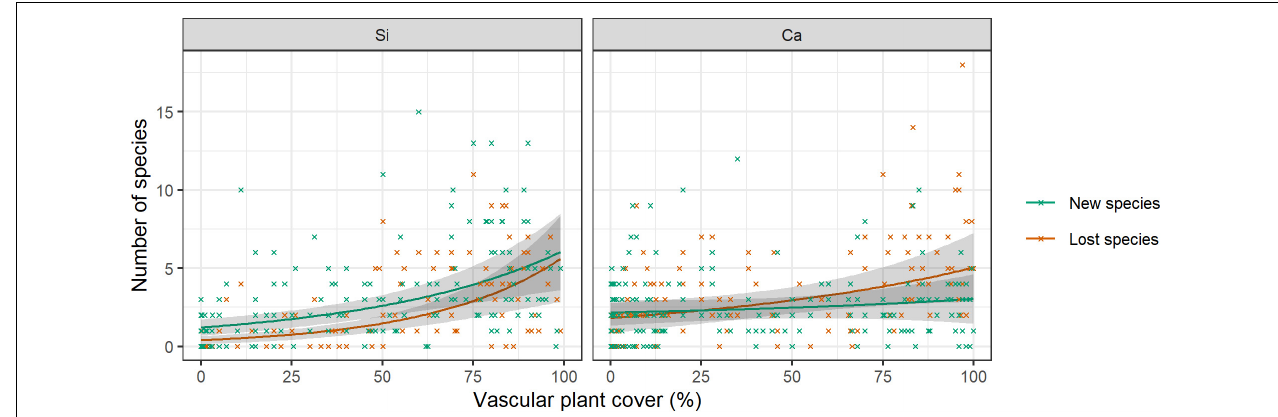
FIGURE 4 | Number of new (green) species and lost (red) species per 1 m × 1 m plot in relation to the vascular plant cover on siliceous and calcareous bedrock. The lines show the predicted mean number of lost or new species ± 95% confidence intervals (in grey) from a negative binomial GLMM. Mean values and standard errors were calculated across aspects and random regions. Crosses represent data. Values and significance levels of the effects are given in Table 5